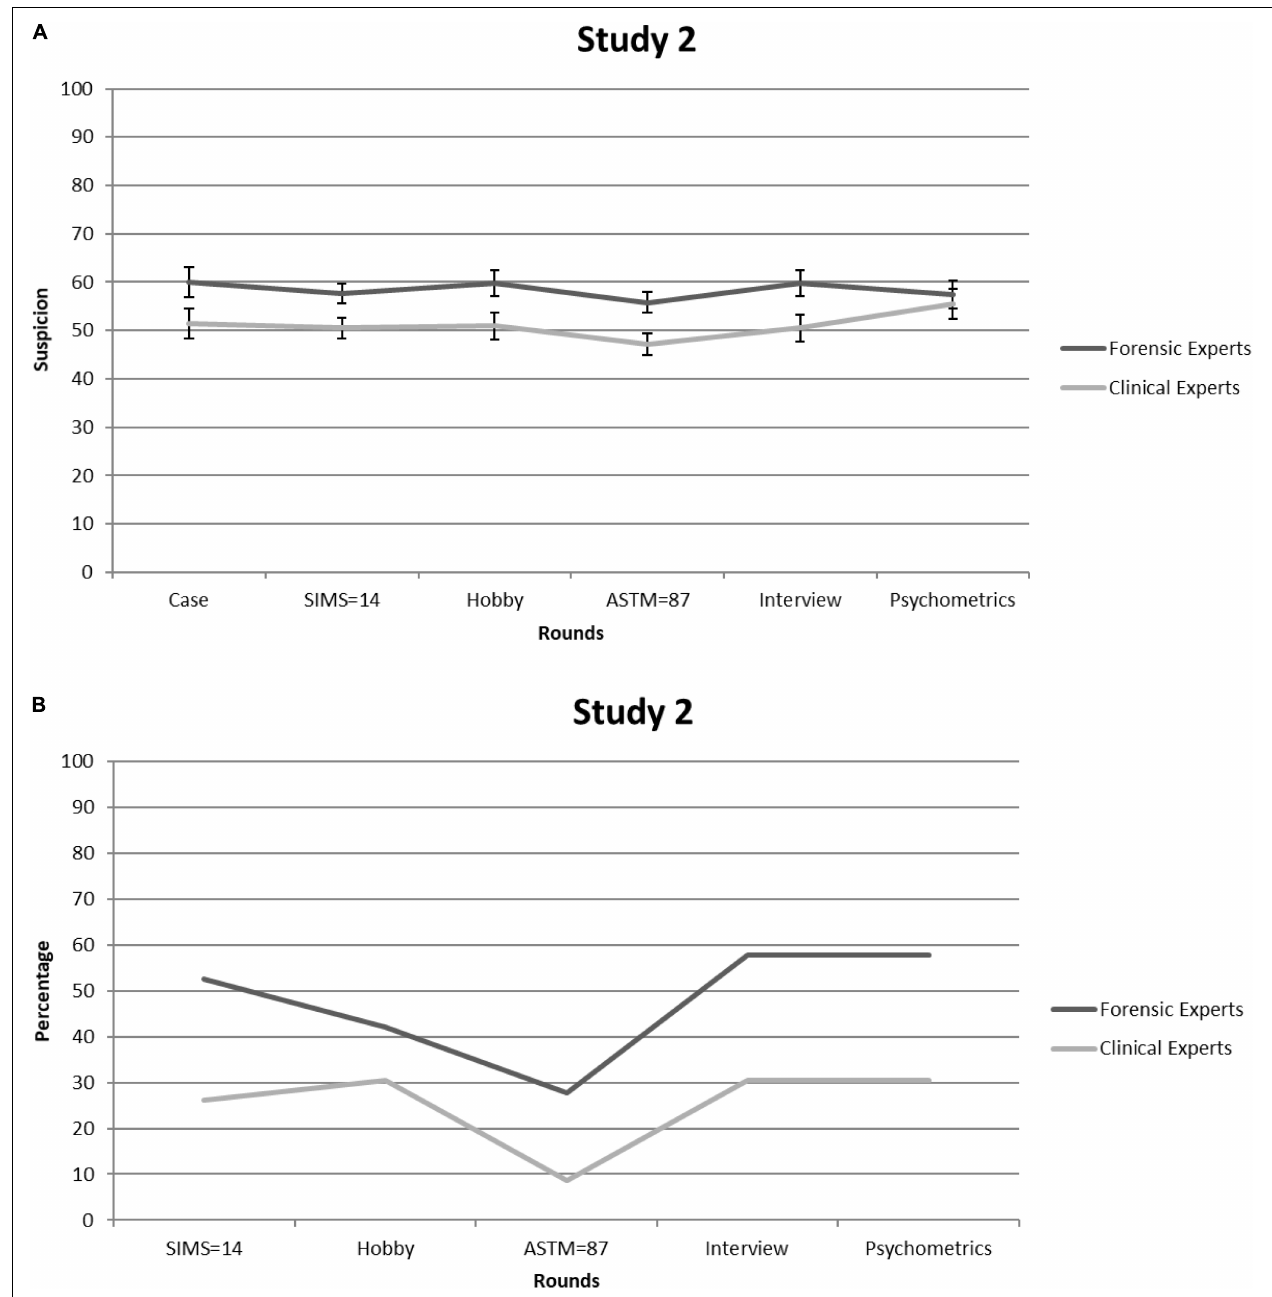
FIGURE 2 | Study 2. (A) Forensic and clinical experts’ mean feigning x confidence ratings after each round. Error bars are Standard Errors of the Mean. (B) Percentages of forensic and clinical experts (per round) who considered mentioning (possible) feigning as a conclusion in their reports.